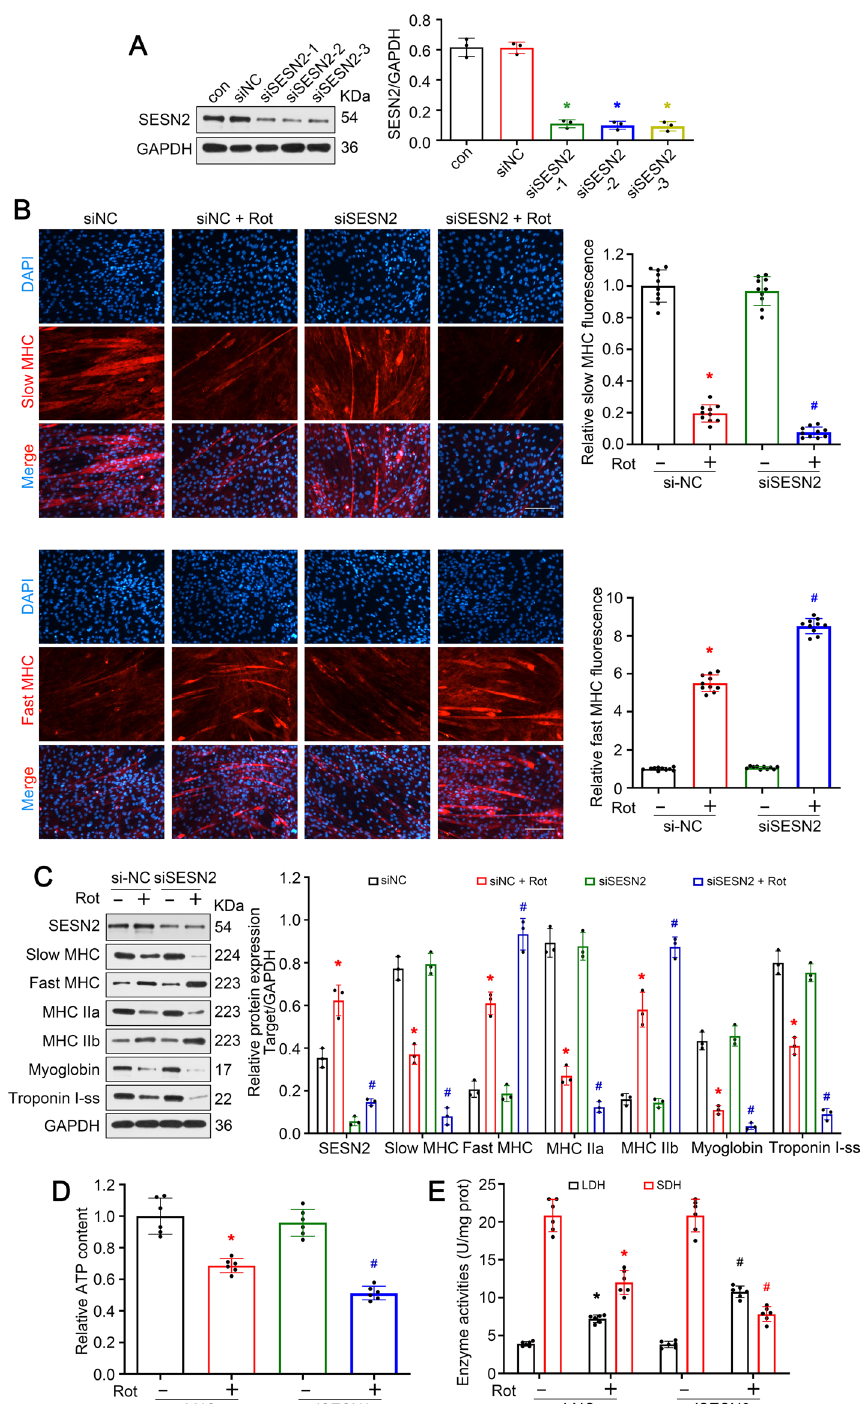
Fig. 4 Knockdown of SESN2 accelerated slow-to-fast fiber type shift in rotenone-treated C2C12 myotubes. A Western blot analysis confirming the effect of siSESN2. B Immunofluorescence analysis of slow and fast MHC. Scale bar, 50 μm. C Western blot analysis of proteins related to muscle fiber type. D , E Detection of relative ATP content and metabolic enzyme activities (LDH and SDH) in C2C12 myotubes. Data presented as mean SD. * P < 0.05 versus siNC group. # P < 0.05 versus rotenone treatment group. Rot ±